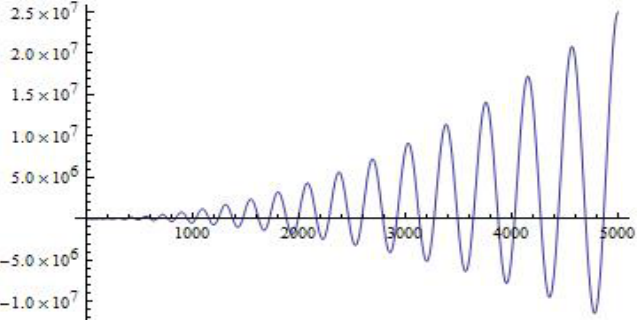
Figure 1. Graph of the characteristic function w ( λ ) . (This graph was sketched by using “Mathematica 8”).